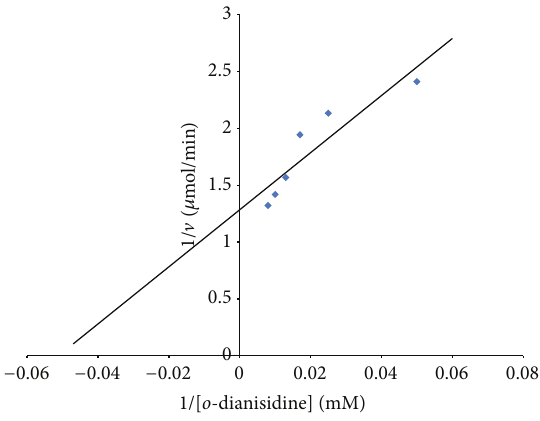
Figure 7: Lineweaver-Burk plot of initial velocity data using different concentration of o-dianisidine as substrate.